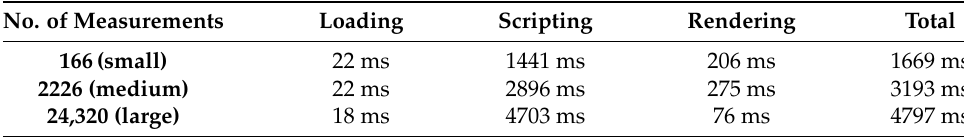
Table 2. Performance of web page. No. of